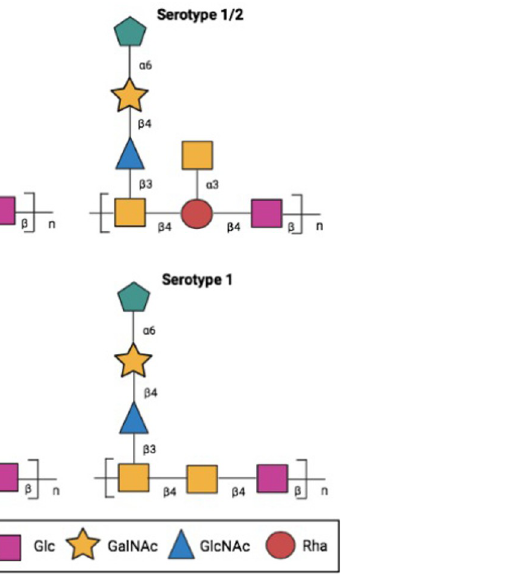
88B5 had cross-reactivity with Staphylococcus aureus , and 111G1 had cross-reactivity with Pseudomonas aeruginosa (Fig 4 and Table 2).